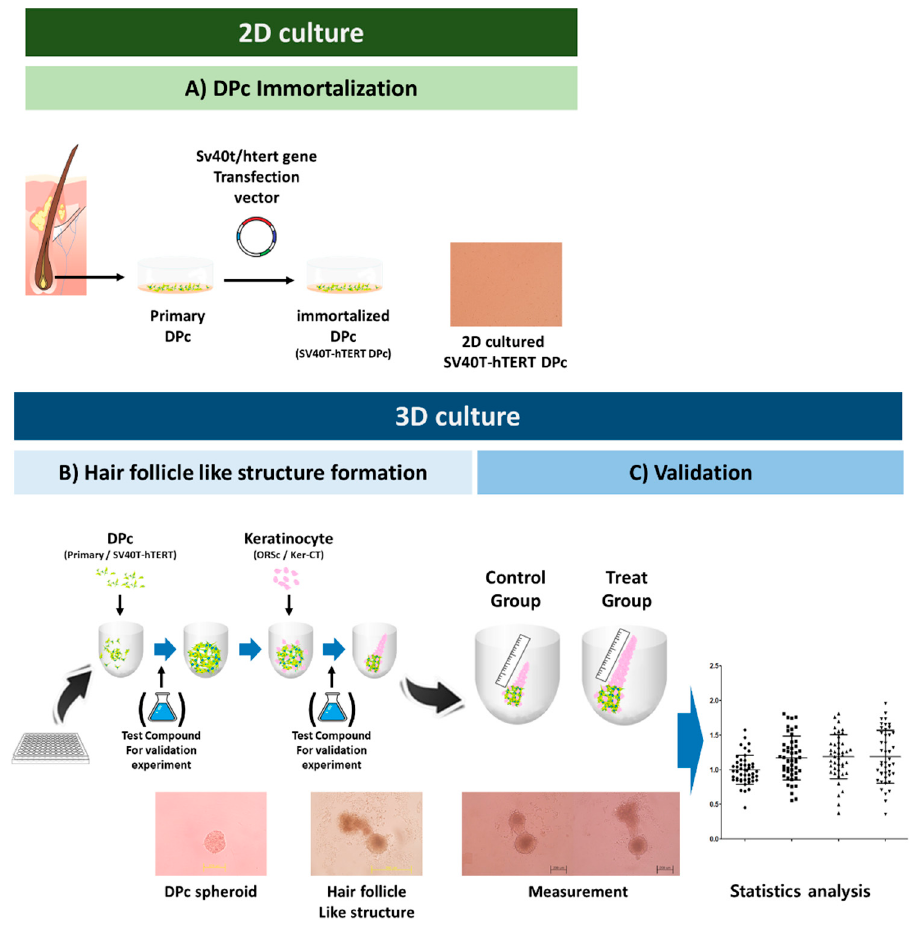
Figure 1. Schematic workflow. ( A ) Human hair follicle-derived cells (DPc, ORSc) were isolated and used in passages 2–3. The SV40T-hTERT DPc, an immortalized dermal papilla cell line, was previously described [17]. ( B ) 3D culture formation for constructing hair- follicle-like structure. ( C ) Quantitative analysis for the validation of the hair-promoting efficiency of the test substances. The elongated keratinocyte layer as observed using a microscope. The quantification obtained using the ImageJ software is presented as dot plots. The different symbols represent different concentrations of test substances.